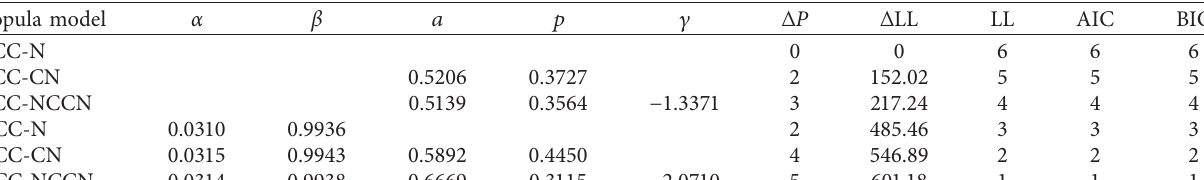
Figure 17: 10% QD coefficient series of the bivariate DCC-NCCN copula model. (a) HSI-CEI. (b) HSI-CCI. (c) CEI-CCI. Table 10: Fitting results of multivariate copula models